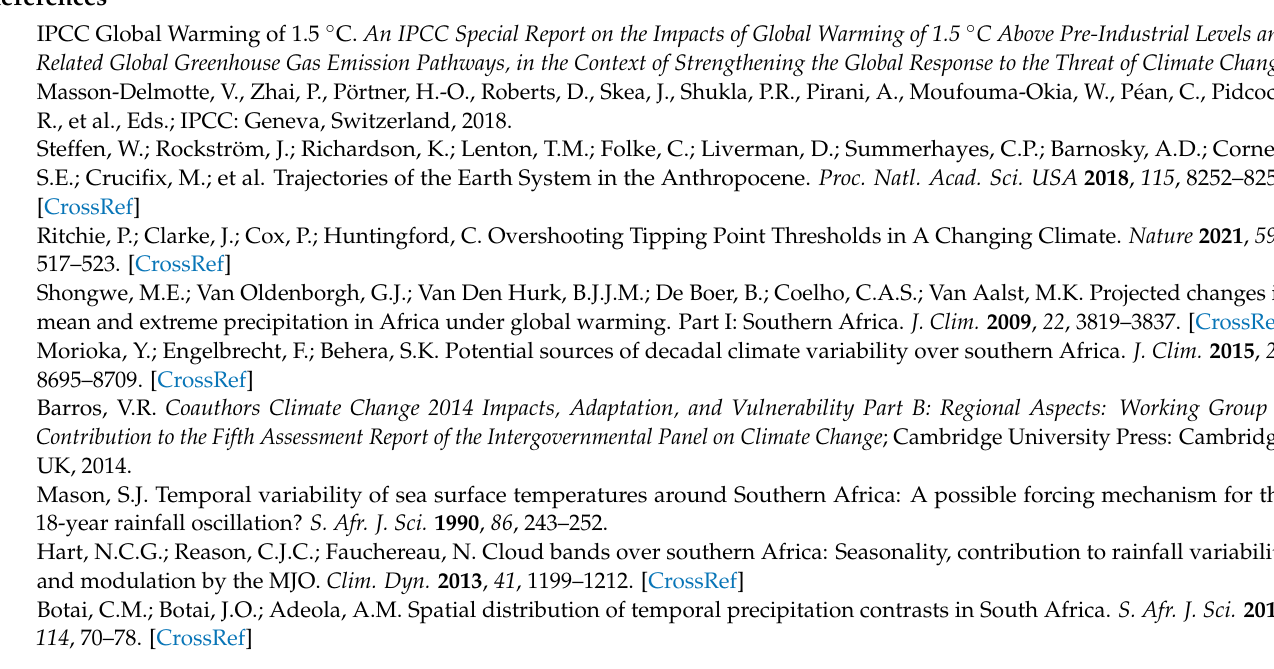
Figure A3. The same as Figure A2, but for the MJJASO season.